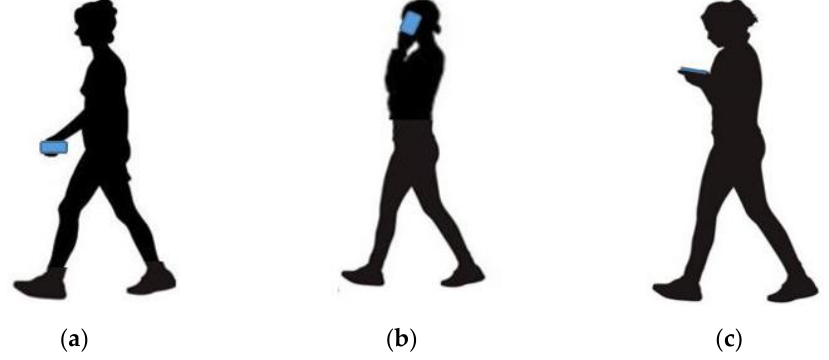
Figure 4. Different phone-carrying modes; ( a ) Swinging; ( b ) Calling; ( c ) Texting.